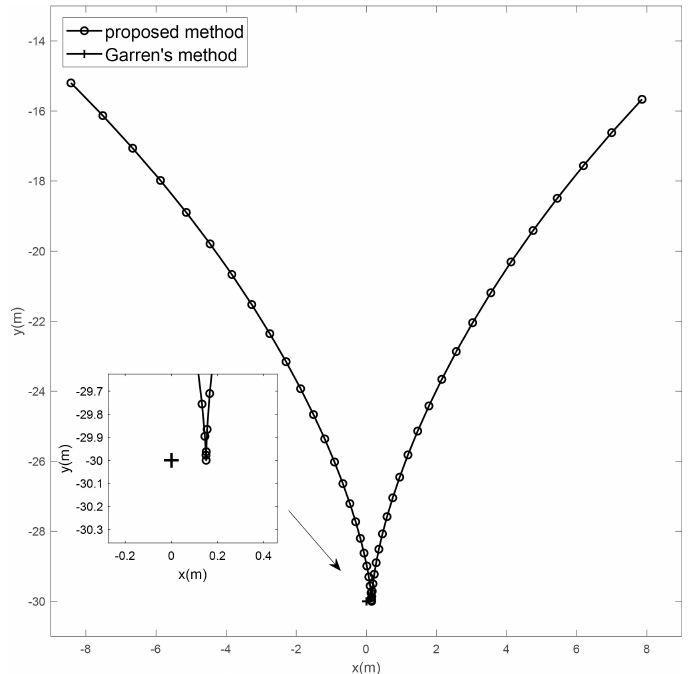
Figure 28. The image traces of the target with azimuth speed of 2 m/s. The target moves from left to right.